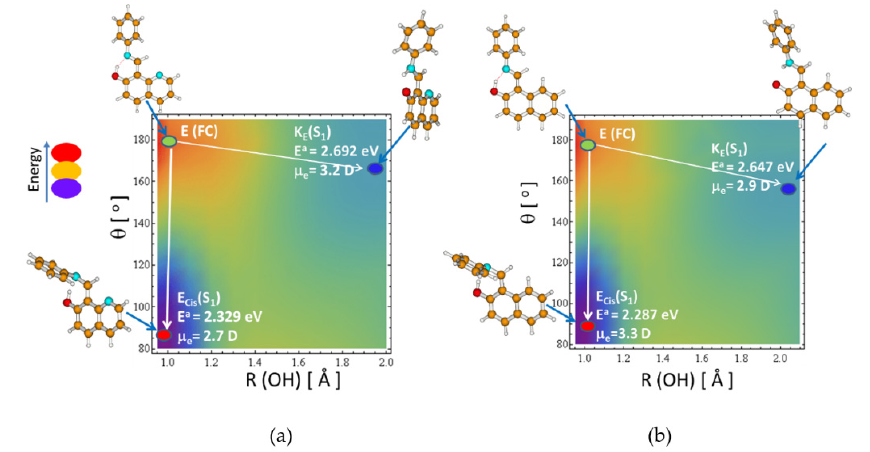
Figure 1. Relaxed potential energy surface of the lowest excited electronic state, S 1 , of 1 ( a ) and 3 ( b ), as a function of R(OH) stretching and θ (C = N) torsion angle coordinates, showing competition between the two processes: E → K E ESIPT and E → E cis photoisomerization after photoexcitation of the S 0 -state E global minimum in the Franck-Condon region. The green circle represents the Franck–Condon region of the ground-state E global minimum initially populated after photoexcitation ( E (FC)), the blue circle represents the excited-state K E (S 1 ) proton-transferred minimum, and the red circle represents the E cis (S 1 ) excited-state minimum. The results were obtained with the aid of the ADC(2)/cc-pVDZ method. S 1 -state dipole moment, µ e , in Debye. Adiabatic energy, E a , in eV.